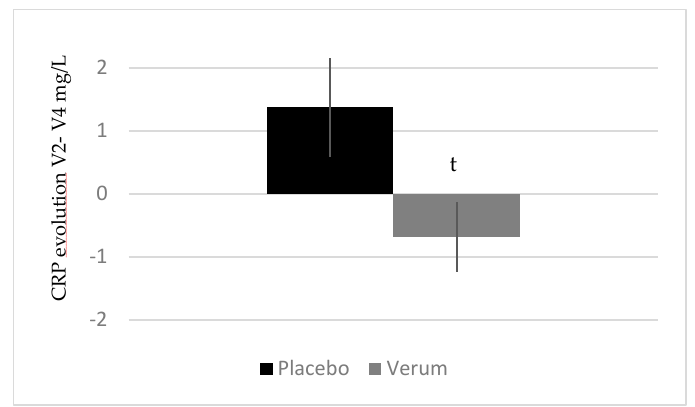
Figure 7. Influence of melon concentrate supplementation on the CRP plasma level. Results are expressed as [CRP] (mg/L) ± SEM. t p < 0.1 effect of the melon concentrate supplementation compared with placebo group.